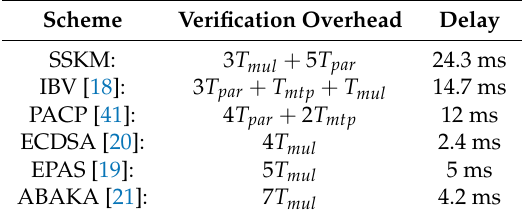
Table 4. Delay comparison of various signature schemes. SSKM, scalable and secure key management scheme; IBV, identity based batch verification; EPAS, efficient privacy-preserving authentication